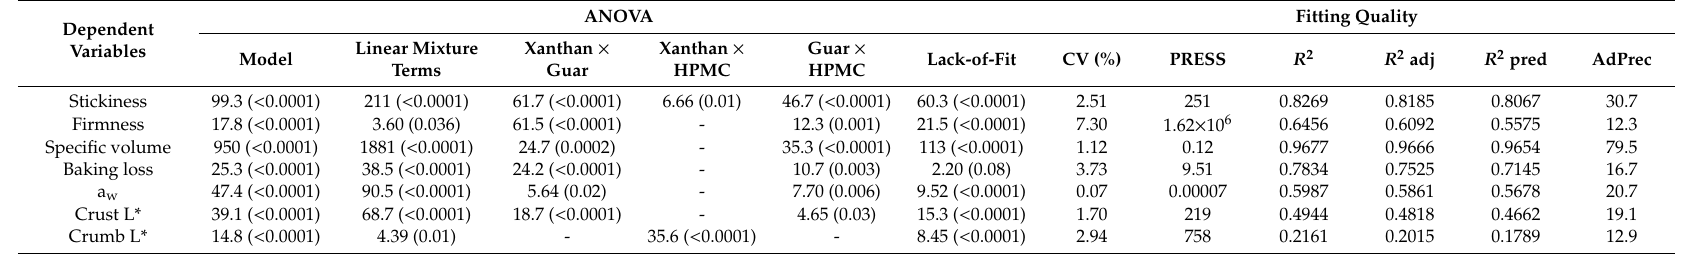
Table 4. Summary statistics of the analysis of variance (ANOVA) showing F-test and p -value (in brackets, Prob > F) of the full model, linear mixture terms, interaction terms and lack-of-fit from polynomial models fitted on the GF batter rheological properties of stickiness and firmness and GF bread physicochemical properties. Goodness-of-fit measures including coe ffi cient of variation (CV), predicted residual error sum of squares (PRESS), coe ffi cient of determination ( R 2 ), adjusted R 2 ( R 2 adj), predicted R 2 ( R 2 pred), and adequate precision (AdPrec) are also